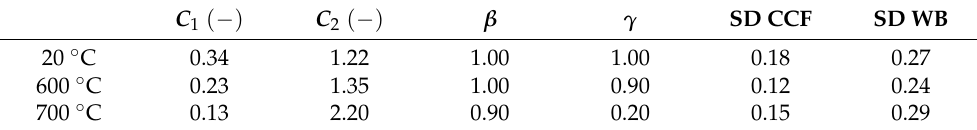
Table 10. Material parameters of Coppola–Cortese damage model at different temperatures.